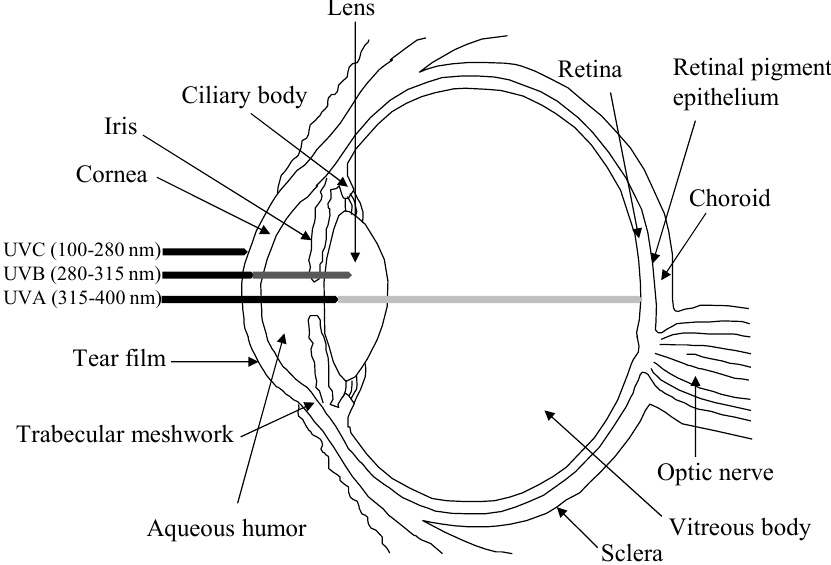
Figure 1. Schematic view of the human eye anatomy and representation of the absorption of UV radiation by the main ocular barriers.